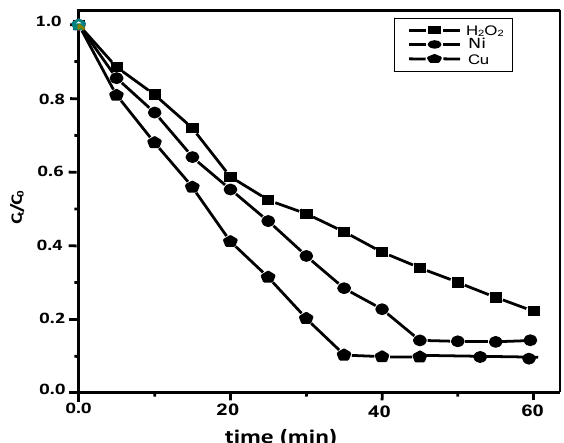
Figure 8. The change in the decolorization of IC over time for photocatalytic degradation by NA- PVA, Cu II /NA-PVA and Ni II /NA-PVA samples. Experimental condition: pH 2, T = 25 °C, catalyst mass = 100 mg, volume = 200 mL, and initial dye conc. 100 ppm.